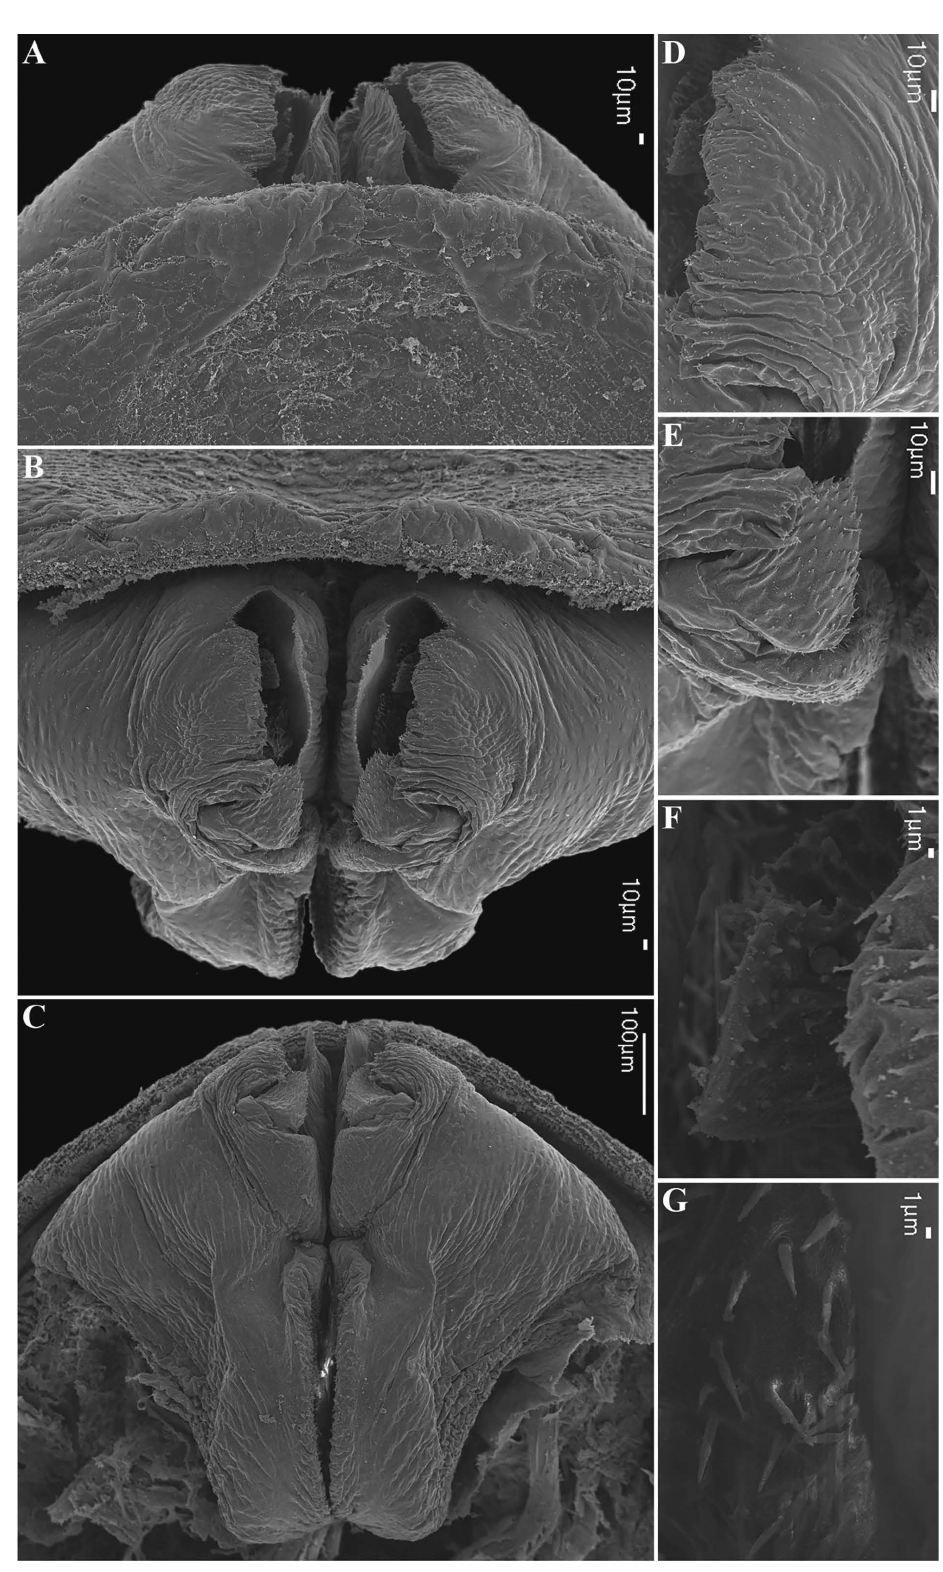
Fig. 123. Sarax rimosus (Simon, 1901) (AMCC [LP 11996]), male gonopod. A . Ventral view. B . Posterior view. C . Dorsal view. D . Dextral side of gonopod. E . Lateral lobe I. F . Processus internus. G . Internal detail of fistula with spiny